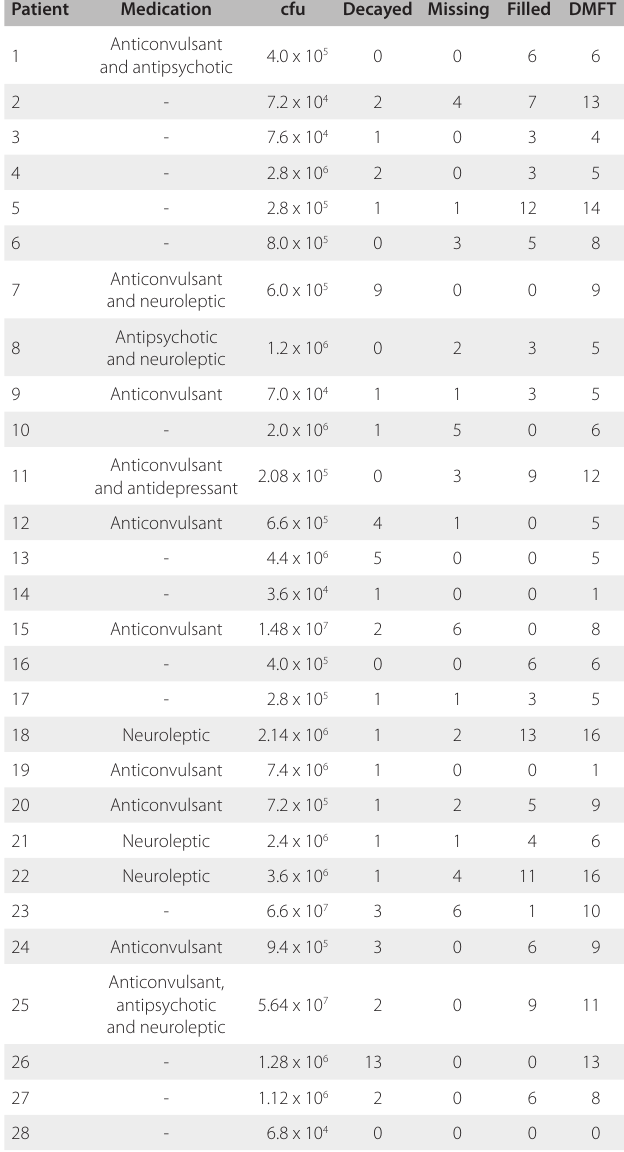
Table 1. Medication in use, number of S. mutans colony-forming units (cfu), number of decayed, missing and filled teeth and the DMFT index for each